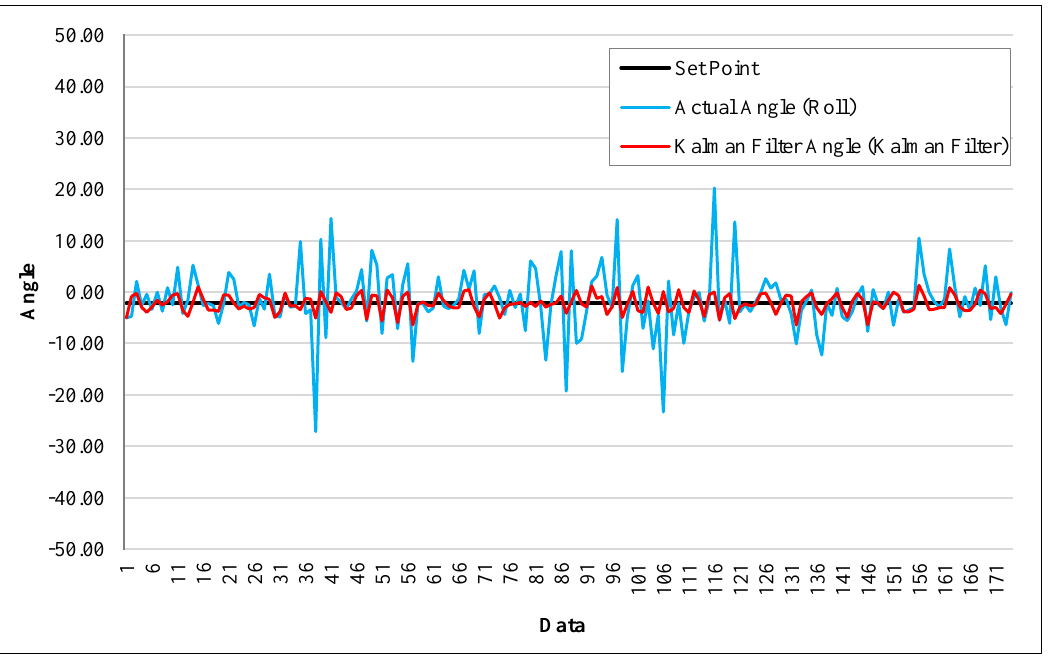
Figure 19. System response to